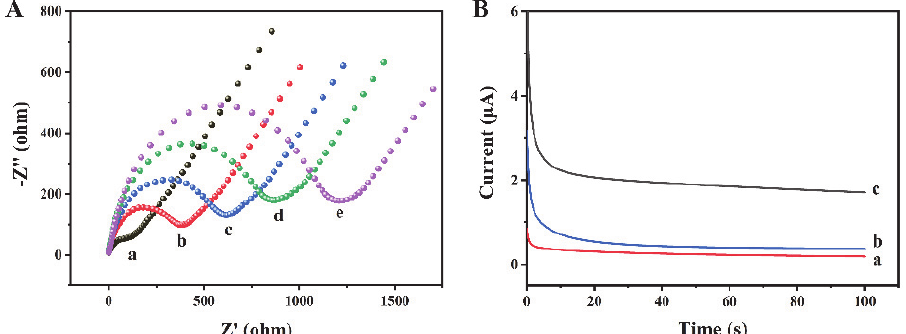
Figure 3. ( A ) EIS measurements of (a) bare gold electrode, (b) Ab1/Au, (c) exosomes/Ab1/Au, (d) Ab2/exosome/Ab1/Au, and (e) Histostar@COFs/Ab2/exosome/Ab1/Au. ( B ) Currents of different electrodes in detection buffer: (a) bare Au, (b) Histostar@COFs/Ab2/exosome/Ab1/Au when the ex ‐ osome concentration was 0 particles/ μ L, and (c) Histostar@COFs/Ab2/exosome/Ab1/Au with 10 6 particles/ μ L concentration exosomes.